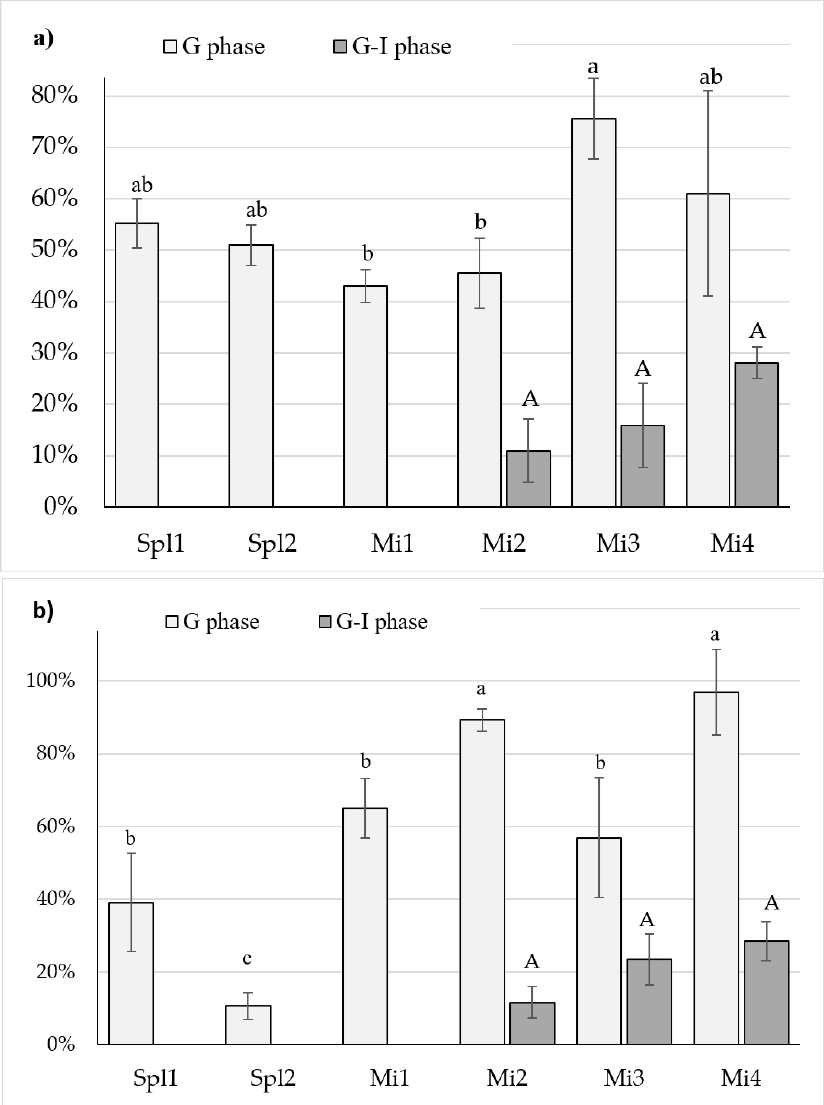
Figure 3. Percentage content of Fe 2+ in the digests of: ( a ) bread; and ( b ) breakfast sandwich in the presence of preparations (Spl1 and Spl2—dietary supplements; Mi1—Mi4 fortifcants of encapsulated iron) after simulated gastric and gastrointestinal digestion. The content was expressed as the percentage of Fe 2+ relative to total ionic iron content (Fe 2+ + Fe 3+ ). Results are presented as the means ± SD; n = 3. Values with the same letter are not significantly different p < 0.05. a, b, c—Letters represent differences between digestates; capital (A): G-I- phase, lowercase (a, b, c): GI-